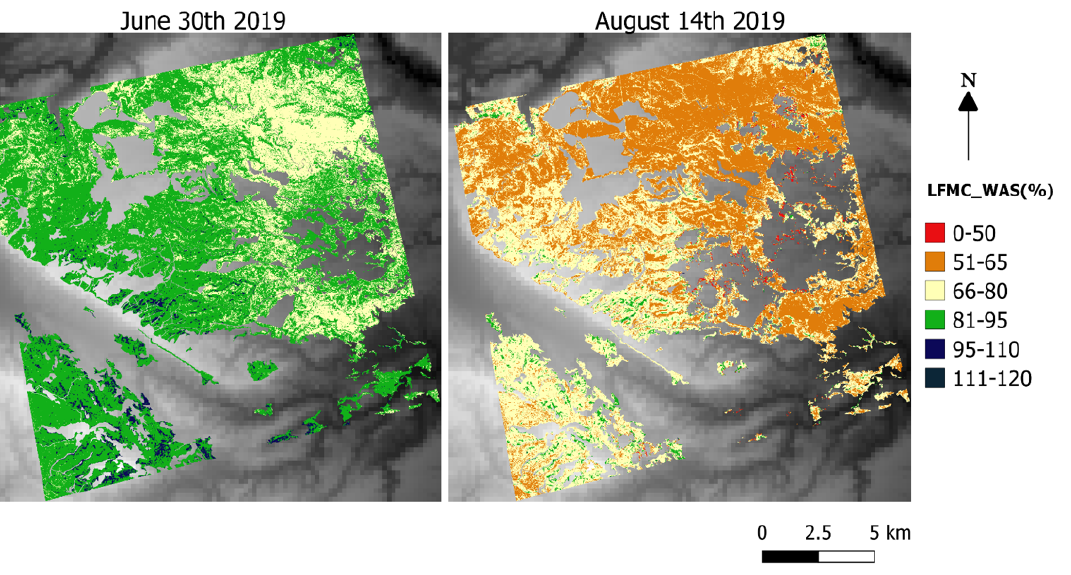
Figure 9. Maps of estimated LFMC_WAS using model (5) in the area covered by a Sentinel-2 scene acquired on 30 June 2019 ( left ) and 14 August 2019 ( right ). Those areas that do not correspond to shrub or sparse woodland according to the Spanish Forest Map were masked out, as were cloudy pixels.